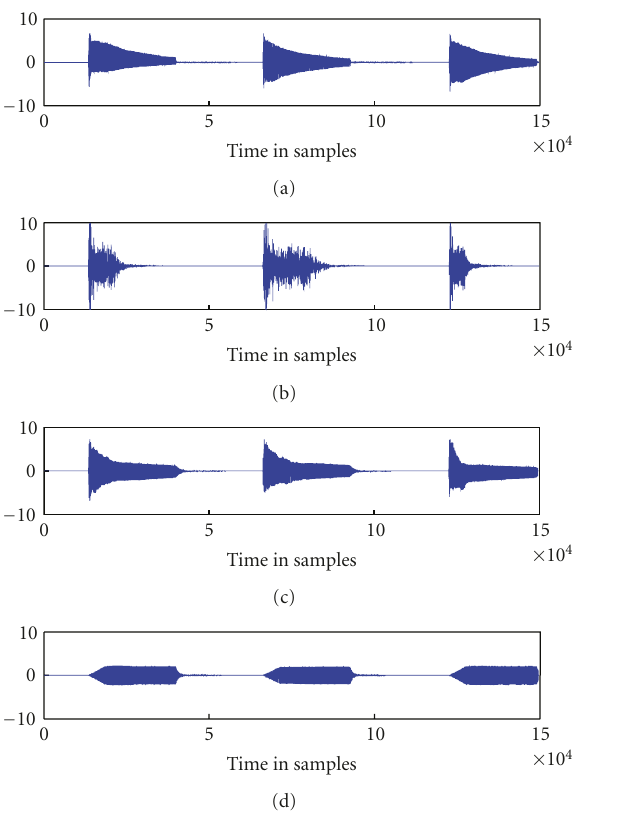
Figure 9: Four music audio signals played (or generated) by a (a) guitar, (b) gun, (c) piano, and (d) whistle, respectively, containing the same notes G4, A3, and E5 as those in the violin signal used in Section 5.1.